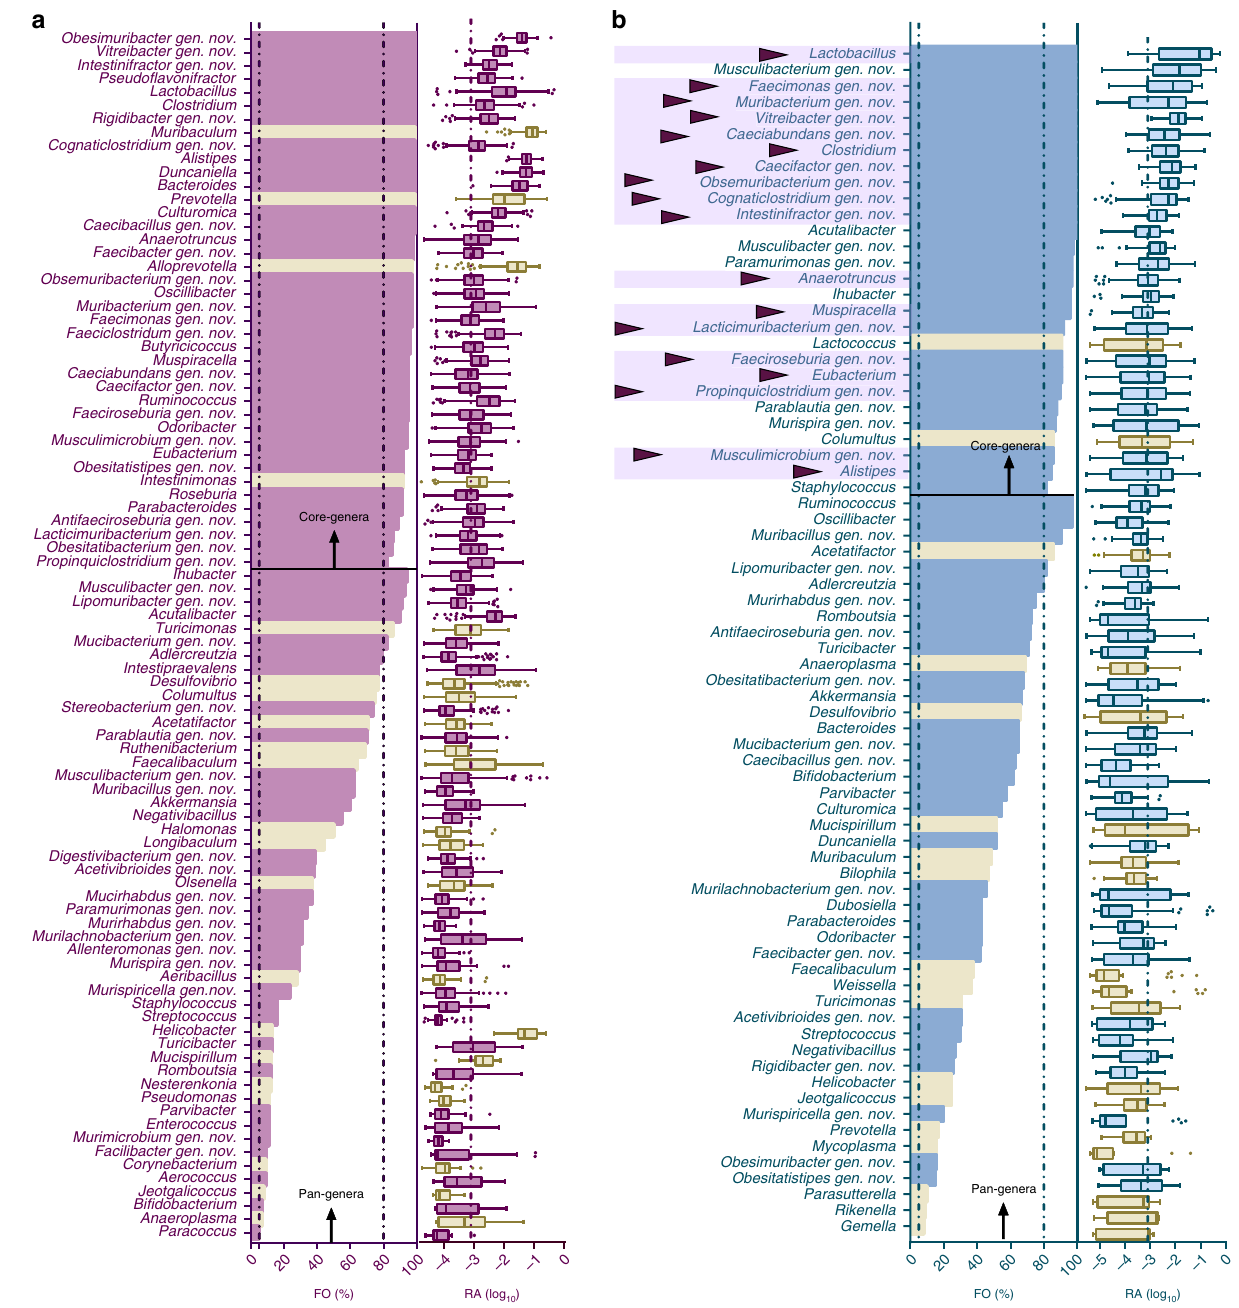
Fig. 3 The mGMB de fi nes the core- and pan-microbiota of mouse gut microbiota. a The mGMB coverage of the core- and pan-genera of the ob/ob mice. b , The mGMB coverage of the core- and pan-genera of the diverse-background mice. The bar chart shows the frequency of occurrence (FO) of each genus in the analyzed samples (de fi nition: FO = 100% is de fi ned when a genus is present in all samples, while FO = 0 is de fi ned when a genus is present in none of the samples), n = 274 in ( a ), n = 93 in ( b ); the box-and-whiskers plot shows the relative abundance (RA) of each taxon, center line: median, bounds of box: quartile, whiskers: Tukey extreme. The RA is exhibited in the percentage value logarithm. Core-genera: genera with FO > 80% and an average RA> 0.1% (log 10 (RA) > − 3); pan-genera: genera with FO > 5%. The cutoff values for core- and pan-genera are marked with vertical dashed lines in the panel; purple/blue: genera covered by the mGMB; cream: genera not covered by the mGMB; purple triangle markers: core-genera for both the ob/ob and diverse- background mice 12 . The n numbers represent the biologically independent samples. Source data are provided as a Source Data fi The total length of the mGMB pan-genome was 548 Mb, from the mGMB. In total, 54.5 and 50.6 gB of metagenomic clean and more than 80.1% of the DNA sequences of the mGMB pan- data were obtained for the OB and WT mouse cecal samples, genome were mapped by the metagenomic reads from either respectively. Then, quality- fi ltered metagenomic reads of both the WT or OB (the outermost yellow layer in Fig. 4a). An analysis OB and WT samples were mapped to the mGMB pan-genome of the mapping results with SAMtools revealed that on average, and the mapping pro fi le was visualized with Anvi ’ o (Fig. 4a). 24.9 ± 3.3% and 24.0 ± 1.9% of the metagenomic reads from OB